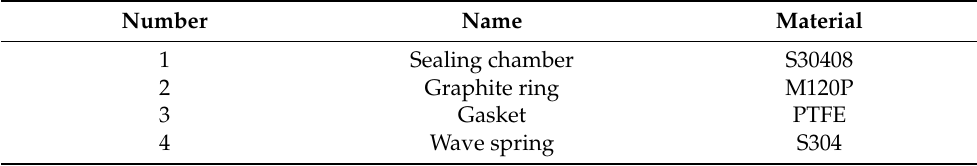
Table 2. Floating ring gas isolation seal assembly materials.